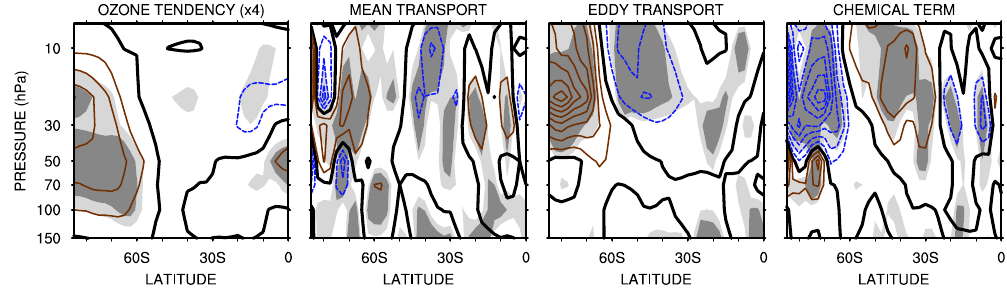
Fig. 7. OND trends in the ozone tendency and its forcing terms for the SH calculated over the 1980–2001 period. Dashed blue (solid brown) lines represent negative (positive) values; the bold solid line represents the zero-line. Light grey (dark grey) shading represents the 95% (99%) statistical signicance level of the trends. Contour spacing is 10ppbvday − 1 per decade. Note that the trends in the ozone tendency are weak compared to the forcings terms and are therefore multiplied by